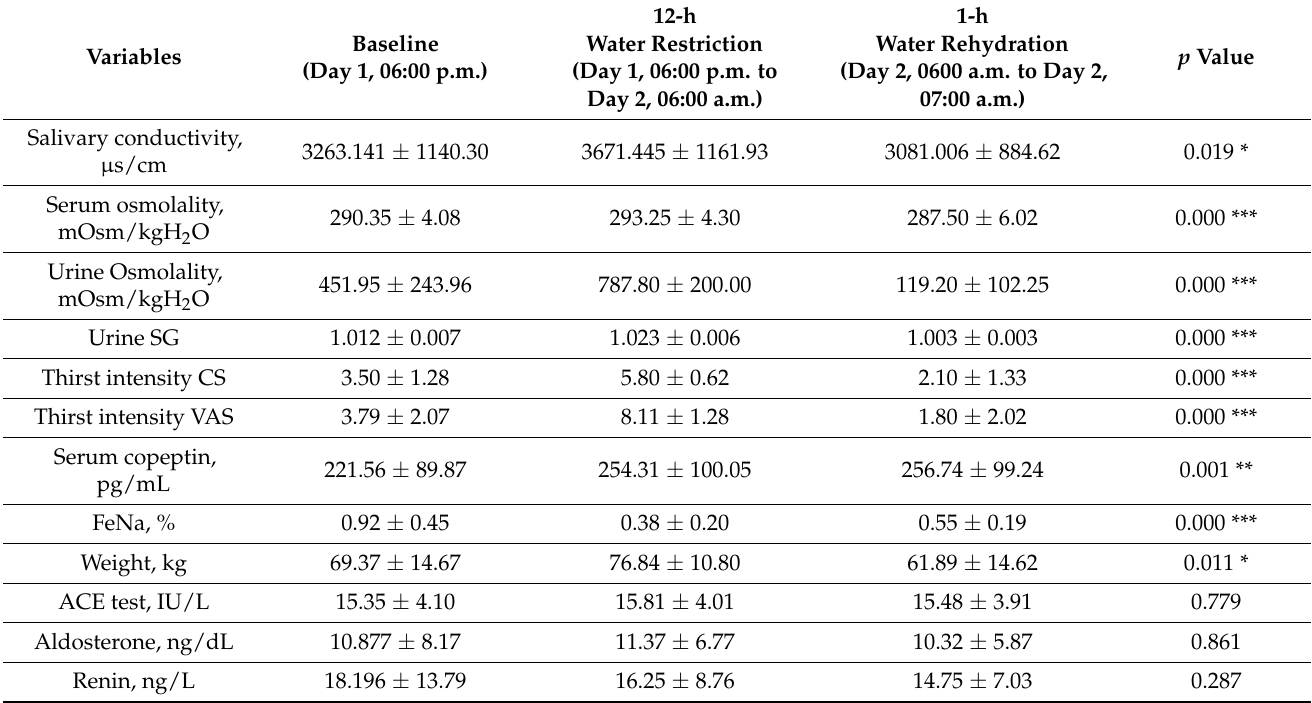
Table 3. Different parameters for the evaluation of body fluid